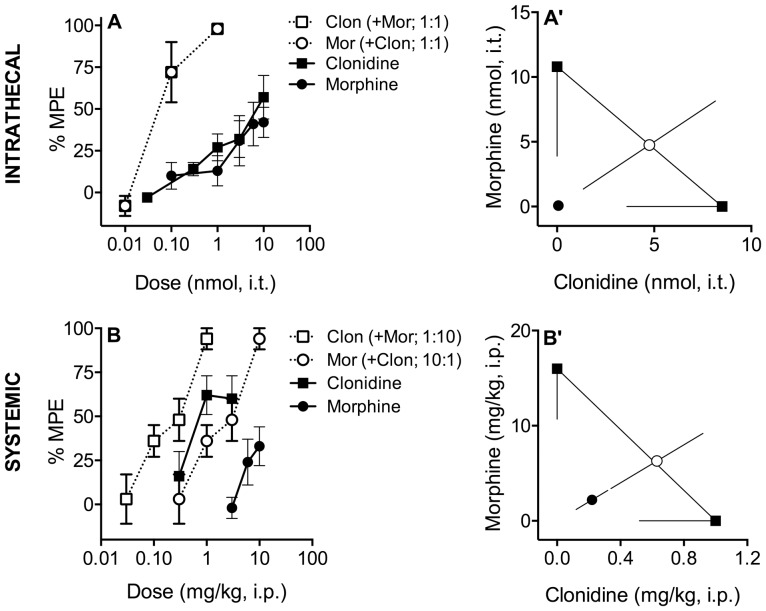
Effects of Morphine and Clonidine in the Tail Flick Antinociception Assay.
A: Intrathecally delivered morphine (•) and clonidine (▪) dose-dependently inhibited thermal nociception with similar potency and efficacy. When co-administered at a constant dose ratio of 1∶1 (○ morphine; □ clonidine), both potency and efficacy were increased. A′: Isobolographic analysis applied to the data from Figure 1A. The y-intercept represents the ED50 for morphine and the x-intercept represents the ED50 for clonidine. The lines directed from each ED50 value toward zero represent the lower 95% confidence limits of each ED50. The line connecting these two points is the theoretical additive line. The unfilled circle on the theoretical additive line represents the calculated theoretical ED50 value of the combination if the interaction is additive. The observed combination ED50 (•) was significantly (p<0.05; t-test) lower than the theoretical additive ED50 (○), indicating that the interaction is synergistic. B. Systemically administered morphine (•) and clonidine (▪) dose-dependently inhibited thermal nociception when administered either alone or in combination at a constant morphine∶clonidine dose ratio of 10∶1 (○ morphine; □ clonidine). B′: Isobolographic analysis applied to the data from Figure 1B. The y-intercept represents the ED50 for morphine and the x-intercept represents the ED50 for clonidine. The observed combination ED50 (•) was significantly (p<0.05; t-test) lower than the theoretical additive ED50 (○), indicating that the interaction is synergistic. Data pictured were obtained 10 minutes following intrathecal (Figures 1A, A′) and 15 minutes following systemic administration (Figures 1B, B′). Error bars represent ±SEM for each dose point (n = 6–10 animals/dose). See Table 1 for ED50 values.